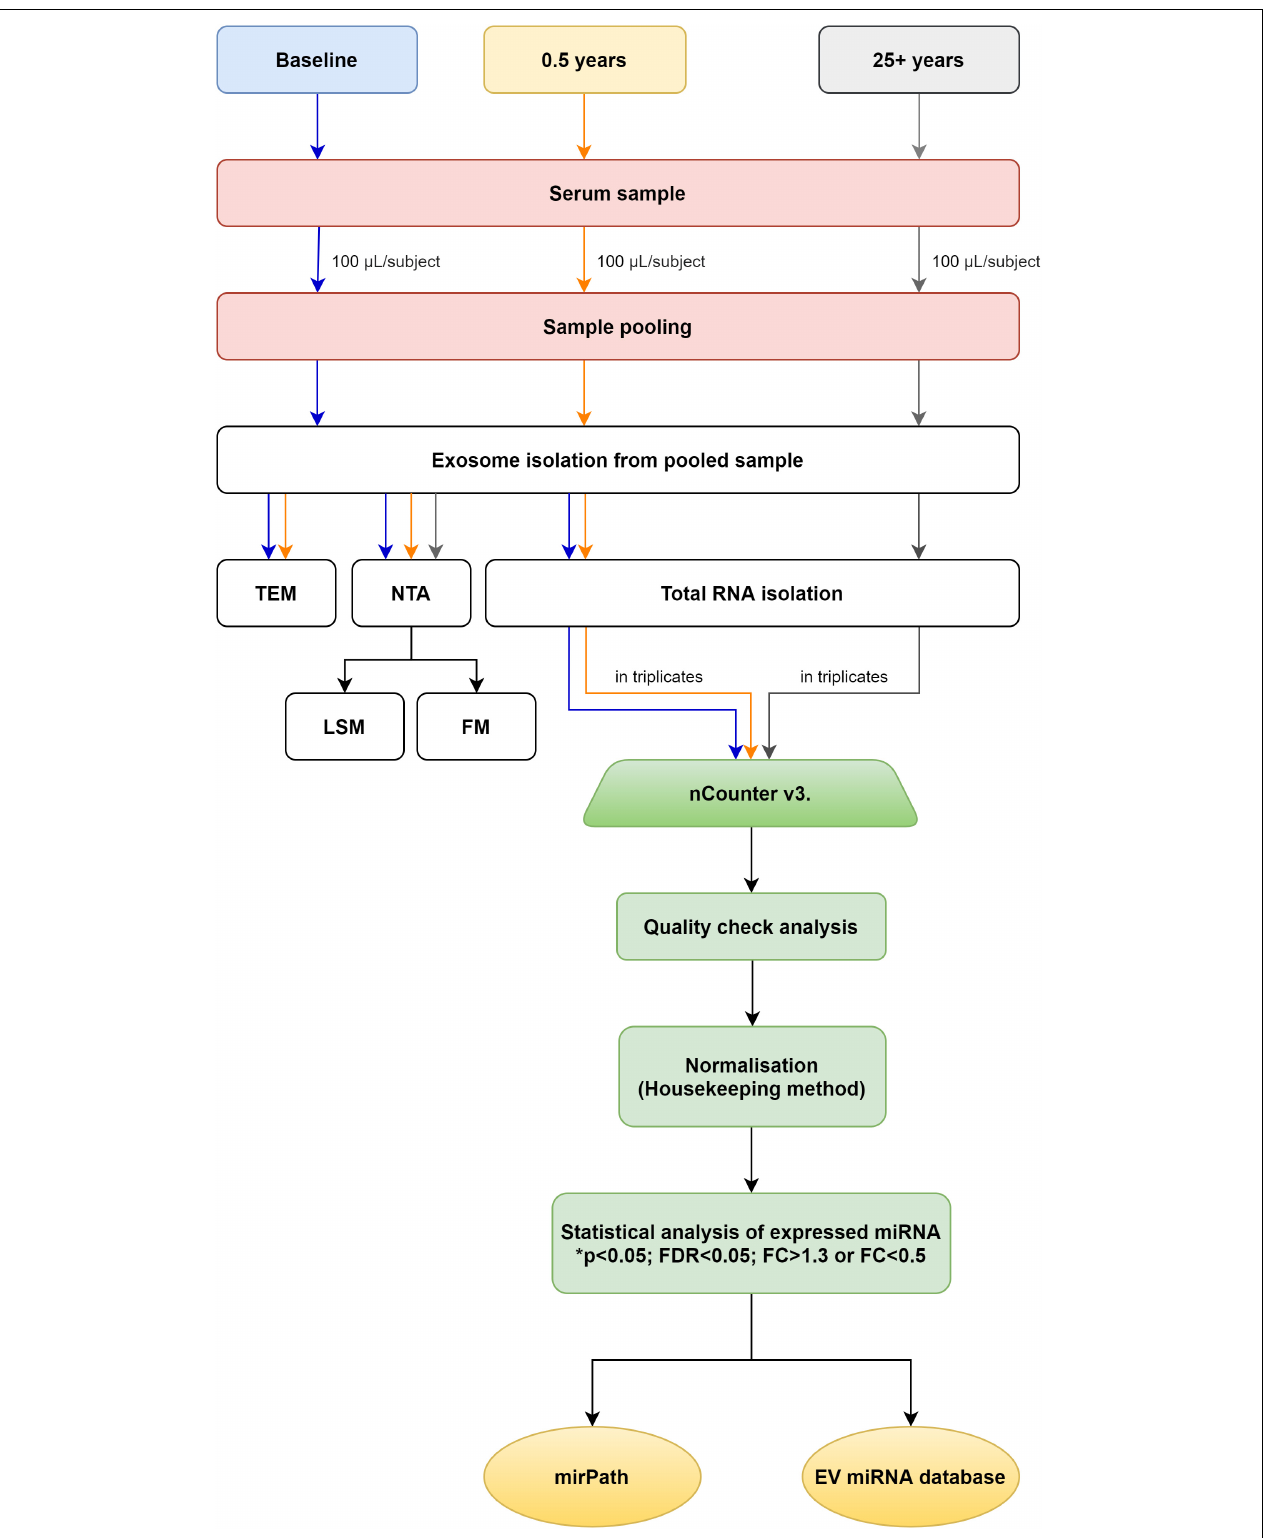
FIGURE 1 | Workflow. Flowchart representing the entire workflow.